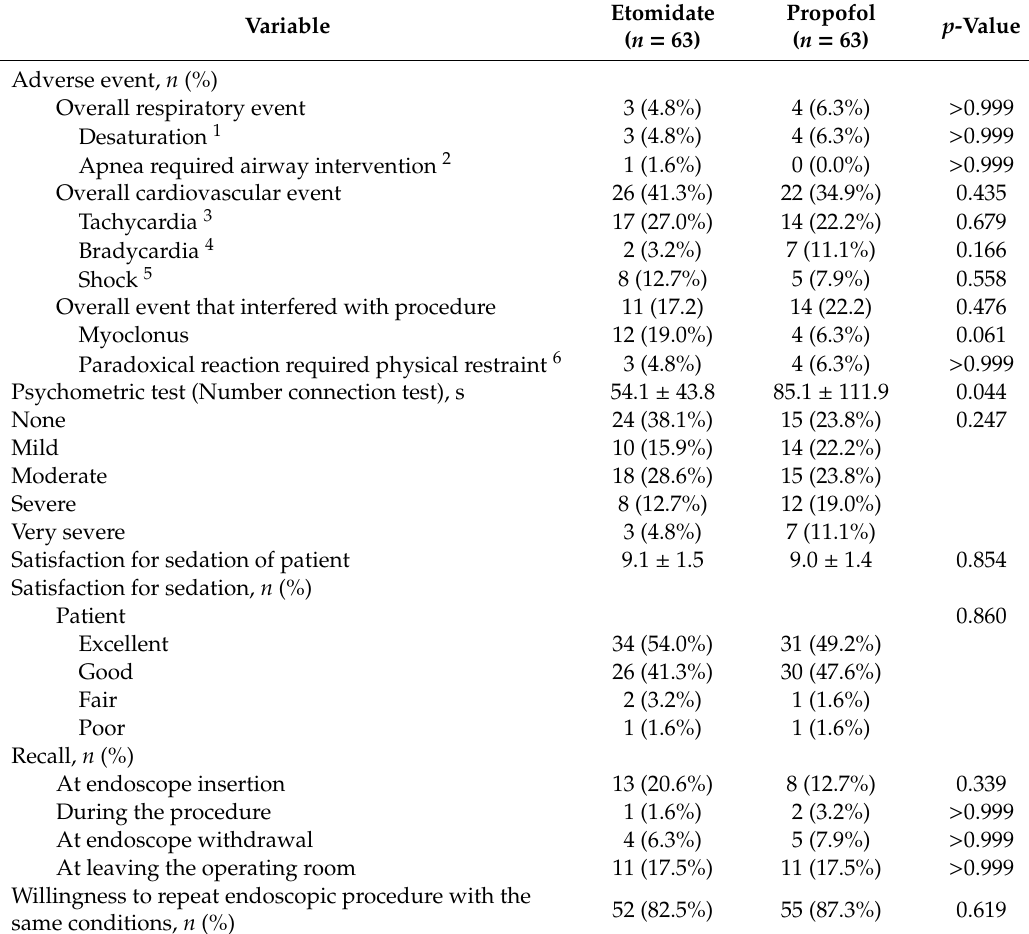
Table 3. Adverse event and satisfaction for